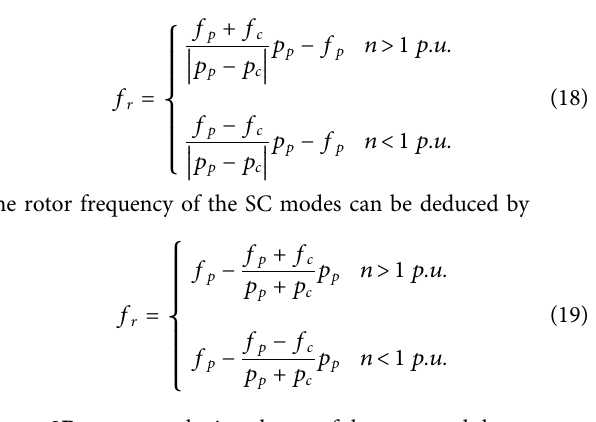
DS-BDFIM with wound rotor